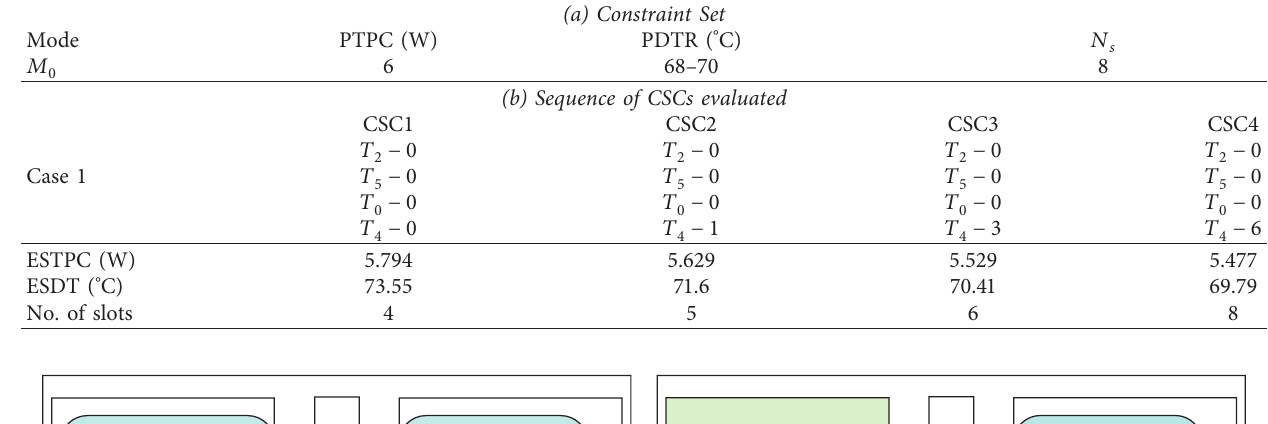
Table 5: Constraint Set and CSCs evaluated for case 1.